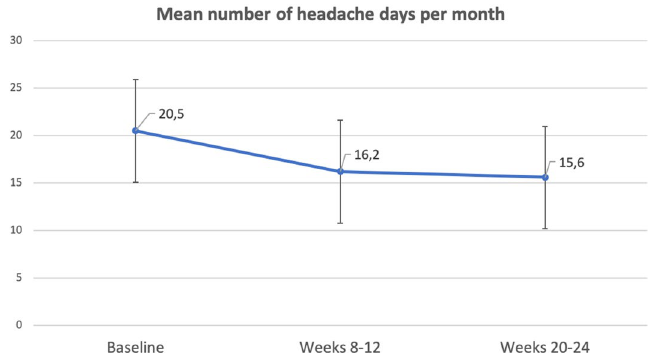
Figure 2. Mean (SD) number of headache days per month in the month prior to candesartan use (baseline) versus weeks 8–12 ( p < 0.001) and versus weeks 20–24 ( p < 0.001) after candesartan use. Paired Student’s t-test. Analysis was intention-to-treat and used the last observation carried forward imputation method.